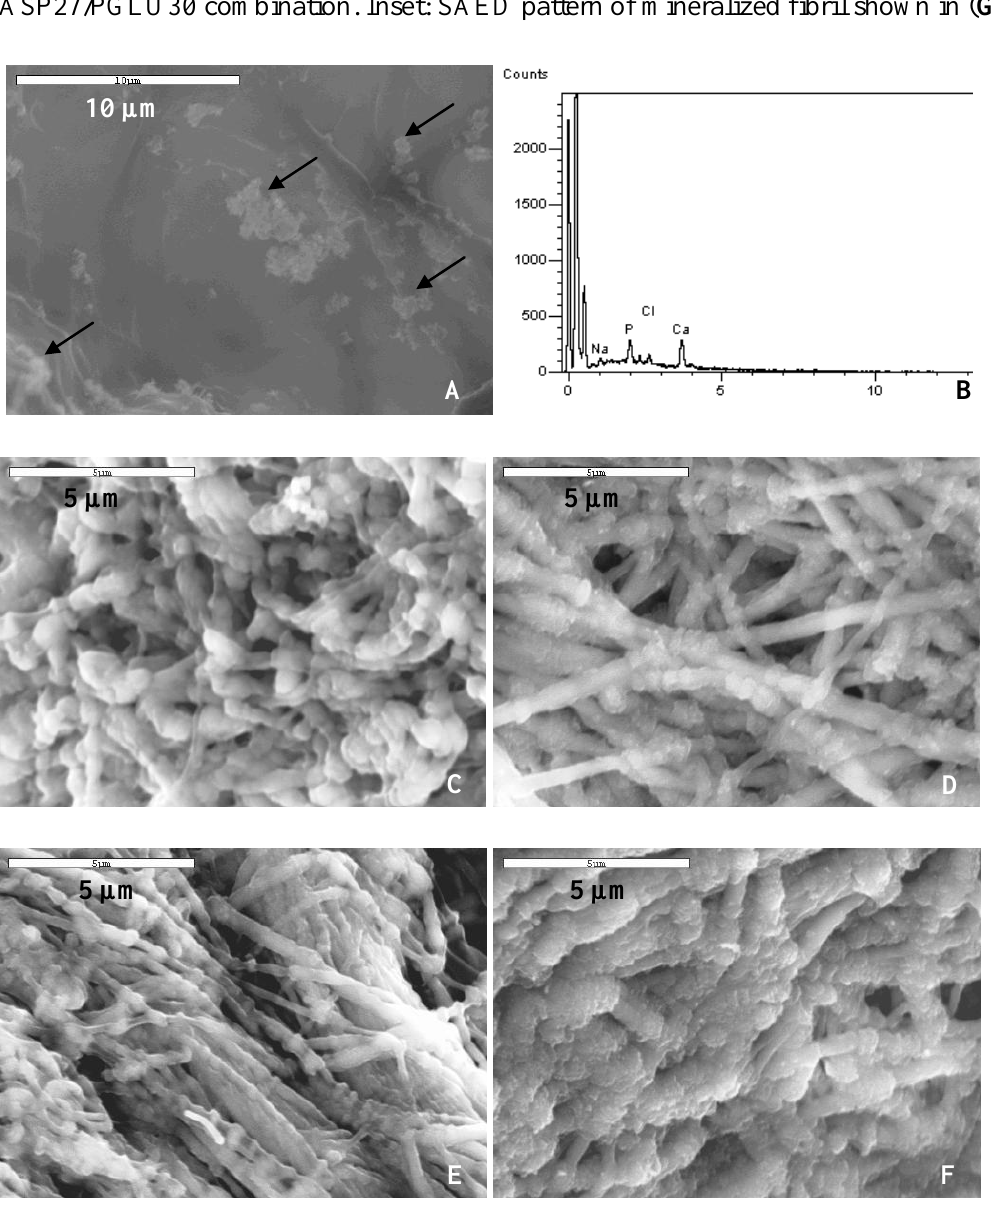
Figure 6. High-magnification SEM of PILP-mineralized collagen samples using poly-L-glutamic acid (30-kDa), and combinations of PASP and PGLU as the process-directing agents. SEM ( A ) and EDS ( B ) of the surface of mineralized collagen sponge treated with PILP solution containing 50 µg/mL of PGLU30 for 6 days. Spherulitic clusters of hydroxyapatite are observed on the surface of collagen sponges treated with PGLU30 (arrows). ( C–F ) Comparison of low versus high molecular weight combinations. ( C ) SEM showing the inner-section of mineralized collagen sponge treated with PILP solution containing 50 µg/mL PASP14 and 50 µg/mL of PGLU15 for 3 days, and ( D ) for 6 days; ( E ) SEM of the inner-section of sample treated with PILP solution containing 50 µg/mL of PASP27 and 50 µg/mL of PGLU30 for 3 days, and ( F ) for 6 days. ( G ) Bright- and ( H ) dark-field TEM micrographs of a PILP-mineralized collagen fibril using the PASP27/PGLU30 combination. Inset: SAED pattern of mineralized fibril shown in ( G